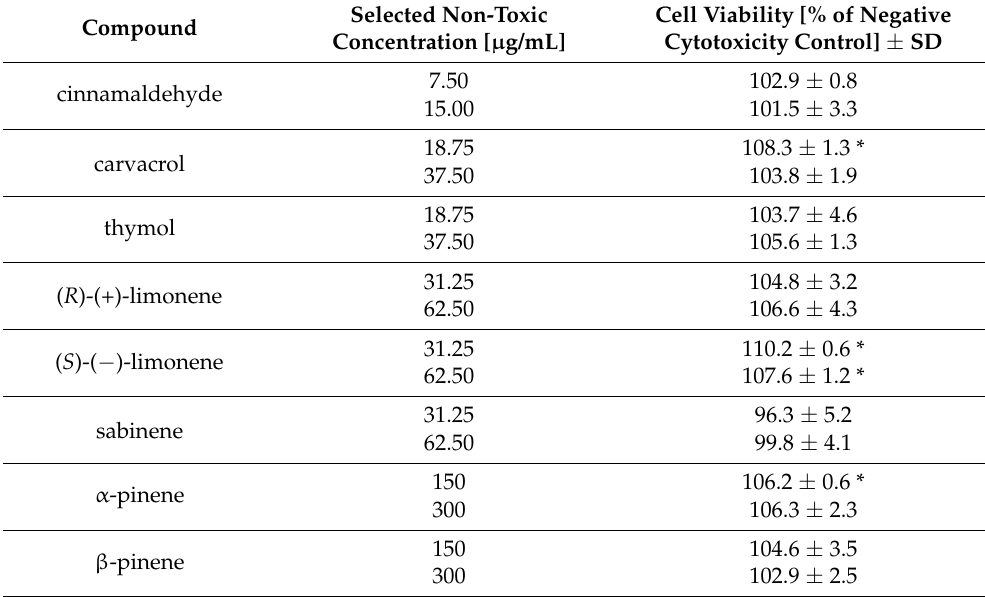
Table 2. Selected non-toxic concentrations of eight commercially available EO-derived compounds based on MTT cytotoxicity